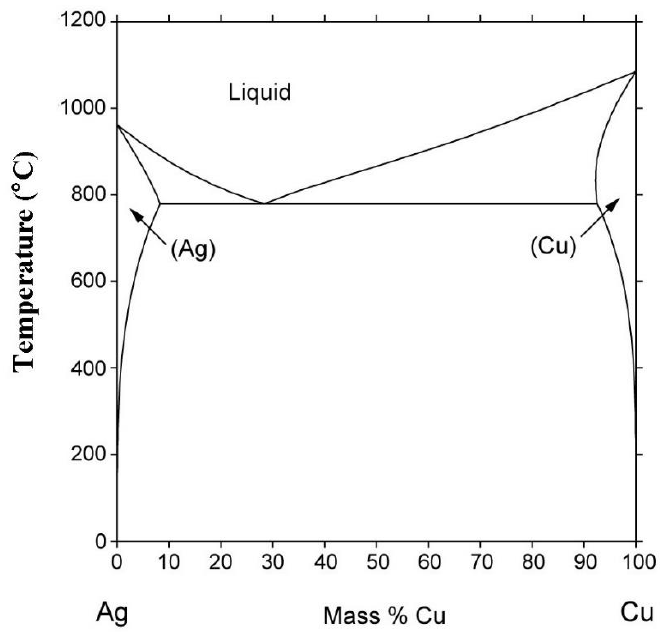
Figure 5. Ag-Cu binary phase diagram (http://www.metallurgy.nist.gov/phase/solder/solder.html (accessed 22 March 2021)). Copyright 2011, with permission from Elsevier.